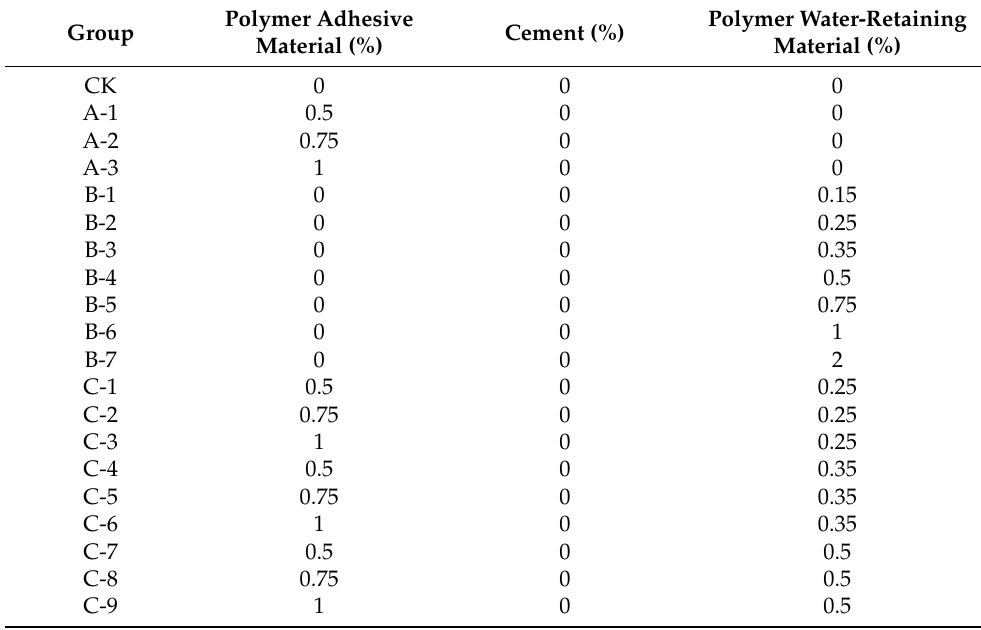
Table 2. Addition of material to the control group and test groups A, B, and C.